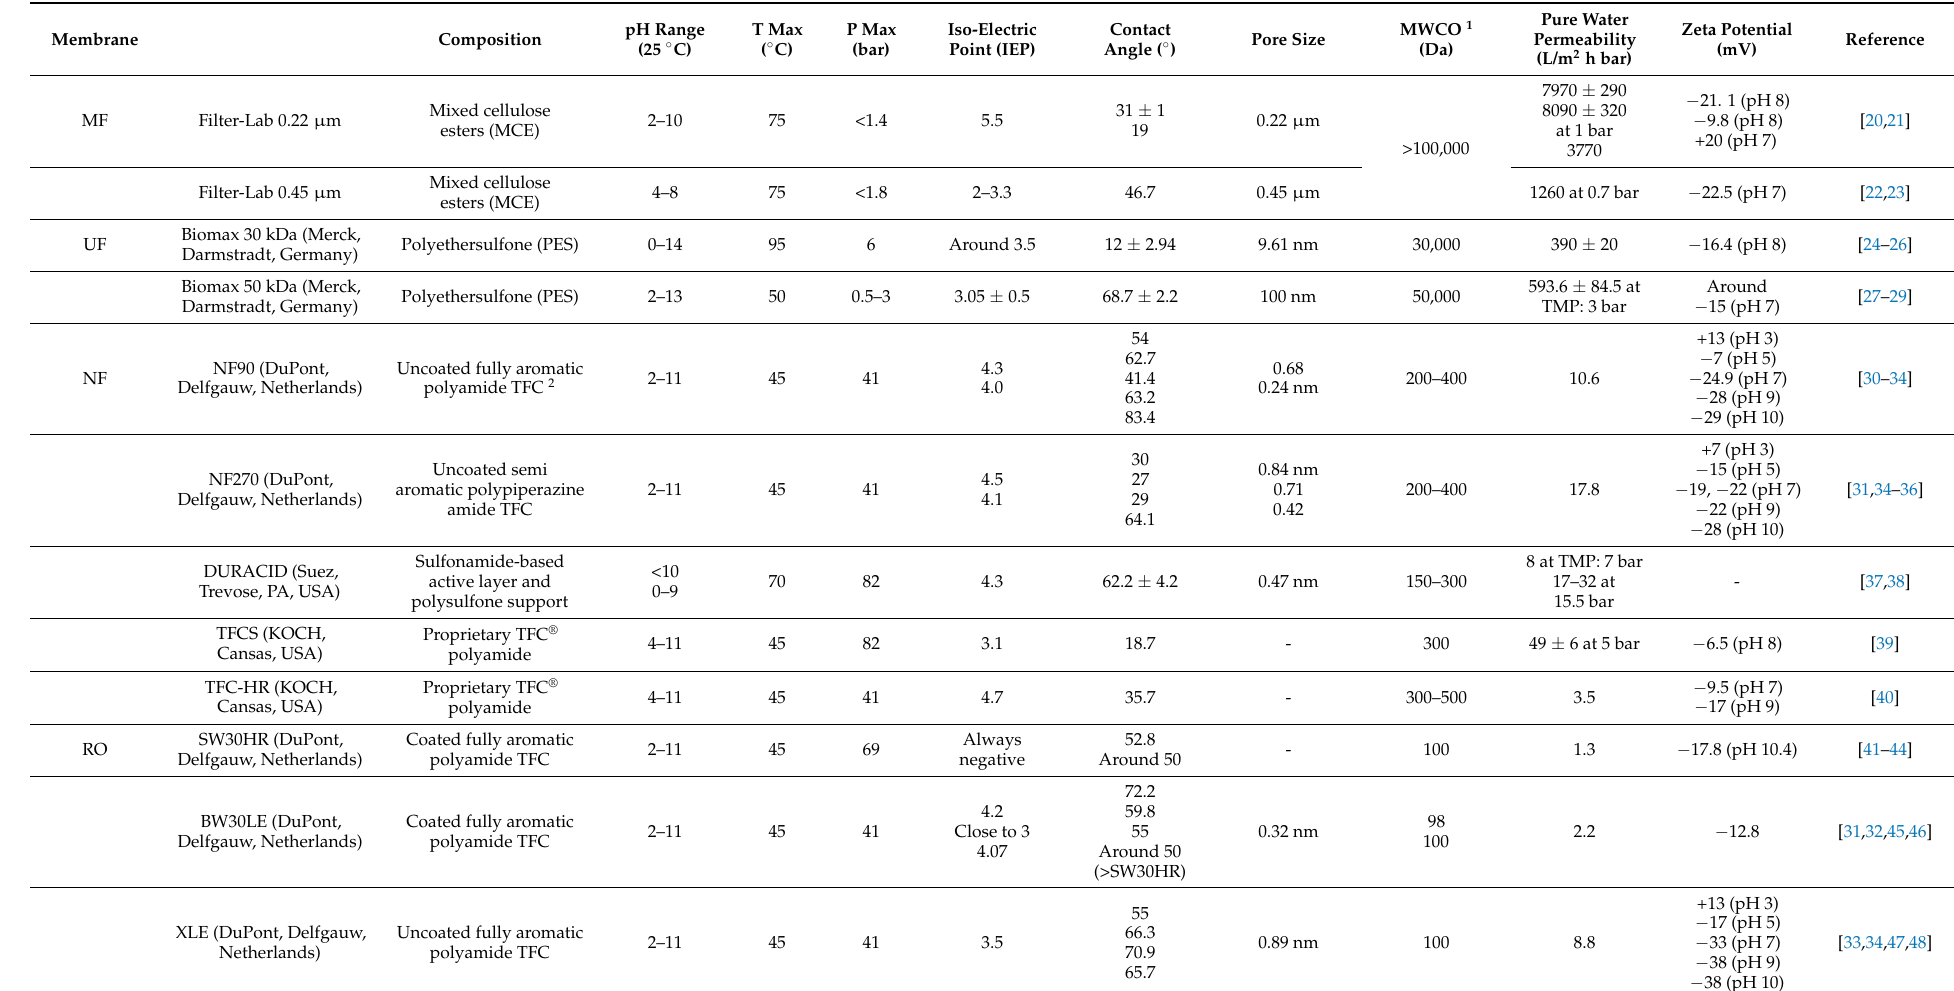
Table 1. Characteristics of the MF, UF, NF, and RO membranes used in this